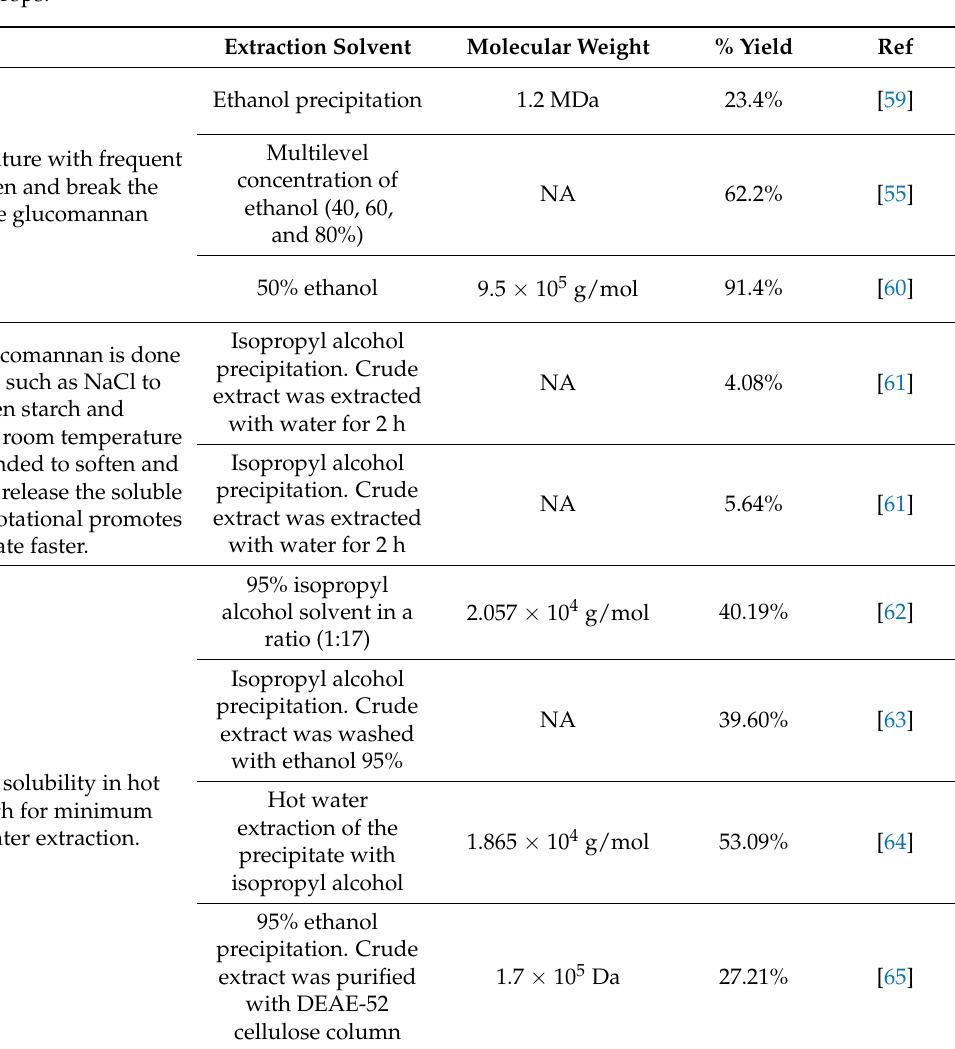
Table 1. Sources and extraction processes of GM from different